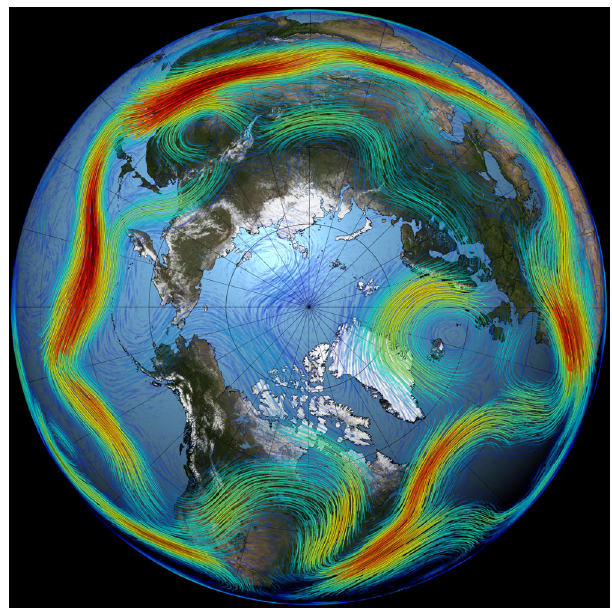
Fig. 1 Arctic sea ice and the mid-latitude jet stream. The mid-latitude jet stream, shown here in red, is one of the components of the atmospheric circulation that is expected to change with Arctic ampli fi cation and decreasing sea ice. For example, the reduced temperature gradient between the two latitudinal bands can cause a weaker and more meandering jet stream. This causes increasingly persistent weather patterns, which in turn can result in extreme events. [Image from NASA/Goddard Space Flight Center Scienti fi c Visualization